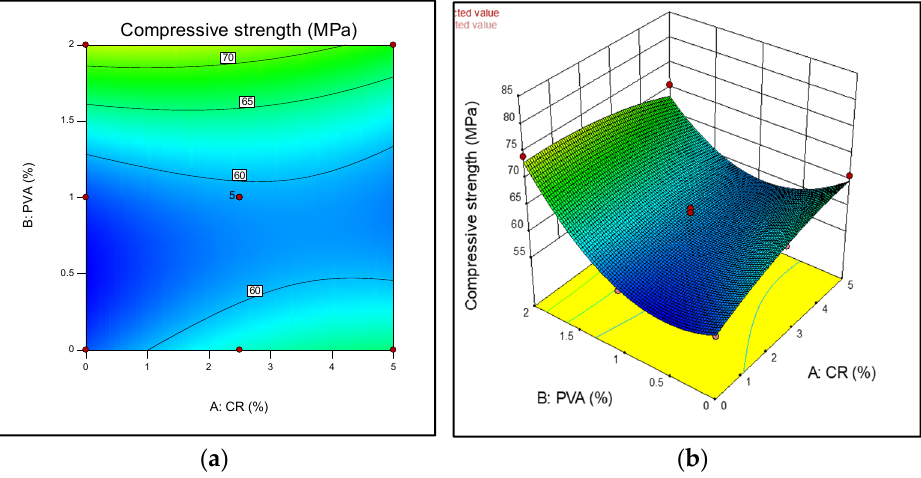
Figure 2. Response surface diagrams for compressive strength. ( a ) 2D contour plot; ( b ) 3D surface Figure 2. Responsesurfacediagramsforcompressivestrength. ( a )2Dcontourplot; ( b diagram.